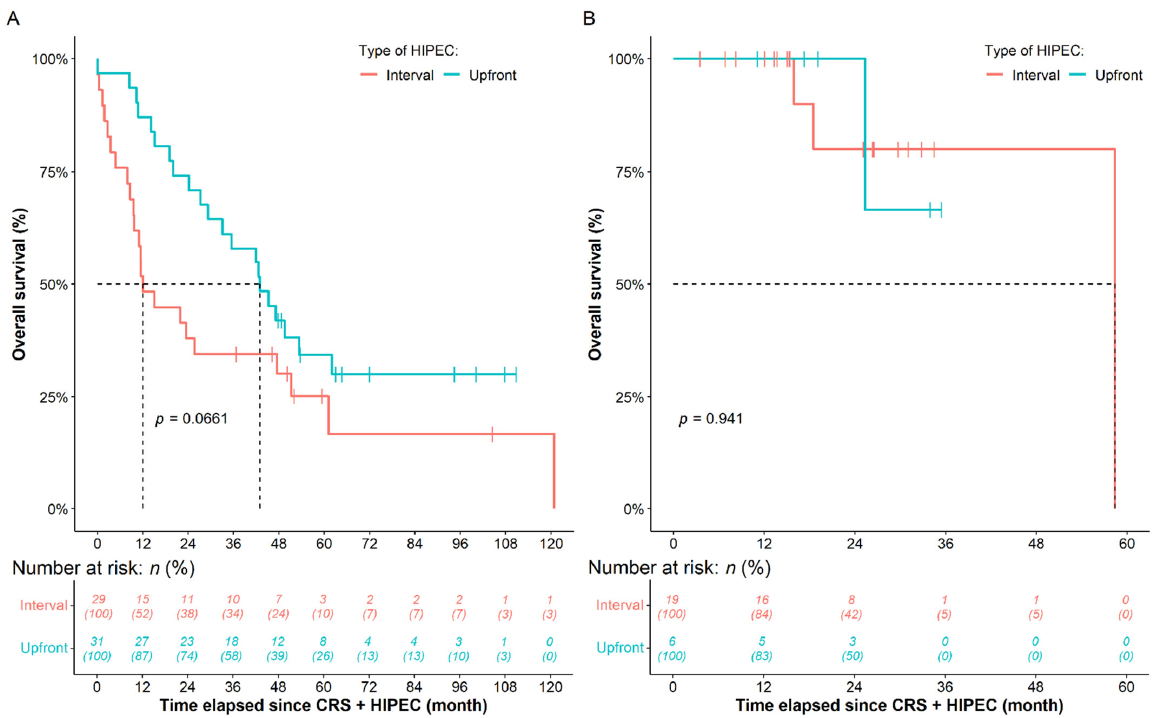
Figure 3. Survival difference of patients receiving neoadjuvant chemotherapy (NACT) prior to the ( A ) 60 min and ( B ) 90min-long HIPEC surgery, compared to those patients who did not receive NACT. CRS: cytoreductive surgery; HIPEC: hyperthermic intraperitoneal chemotherapy.